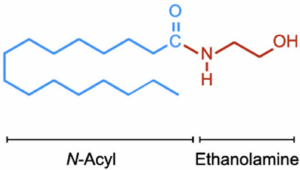
Figure 1. Chemical structure of PEA. For the N -acyl side chain, the nomenclature is (16:0) given that there are sixteen carbon atoms and no double bonds between the carbon atoms. The corresponding numbers for OEA and AEA are (18:1) and (20:4),